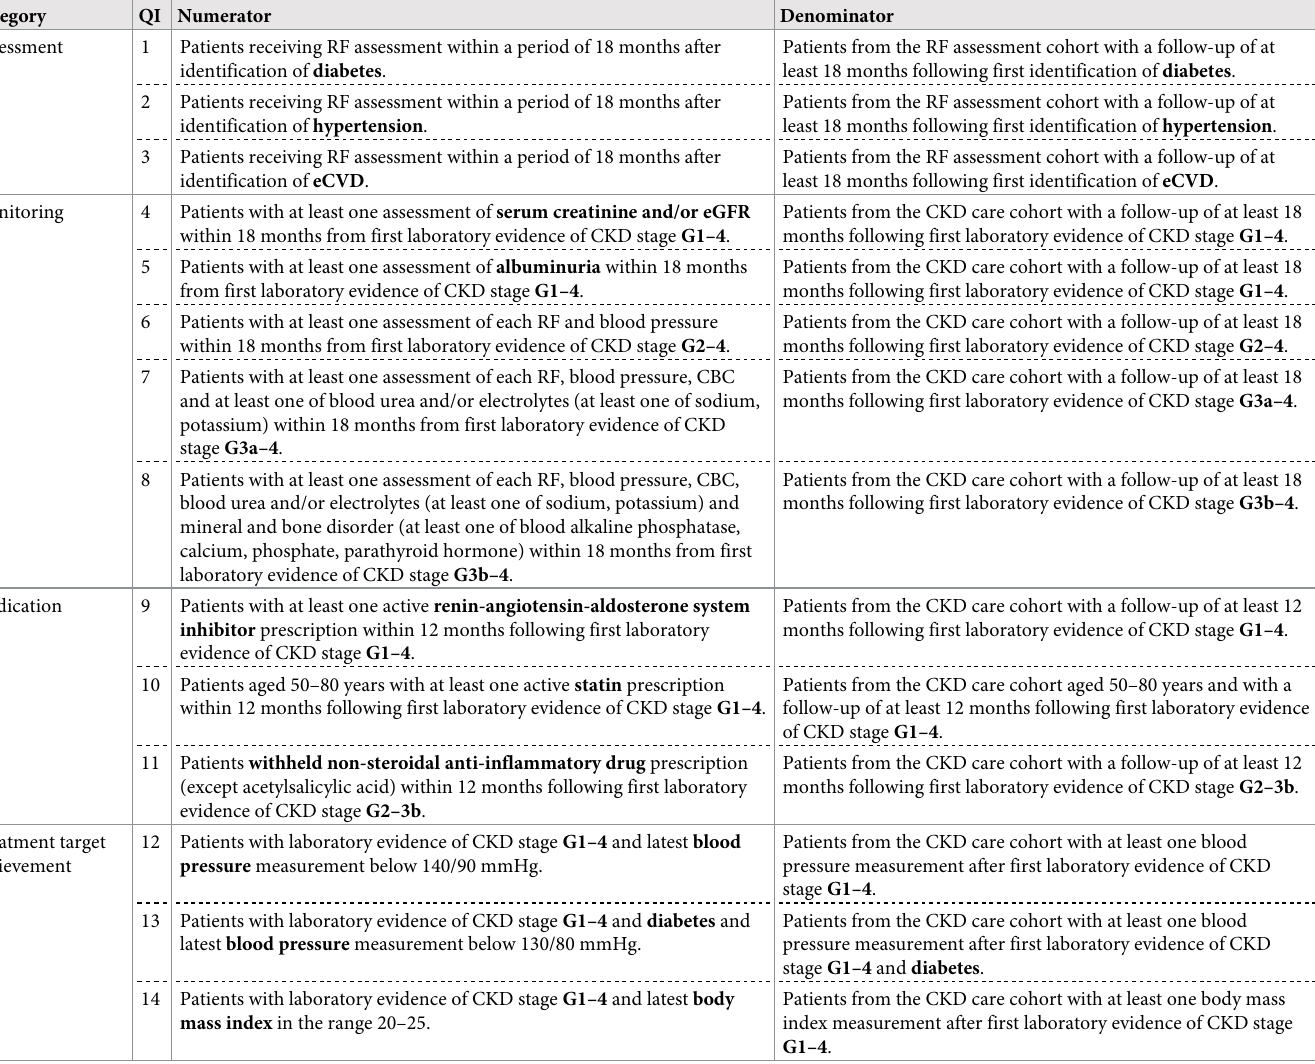
Table 1. Definition of quality indicators. Category QI Numerator Denominator